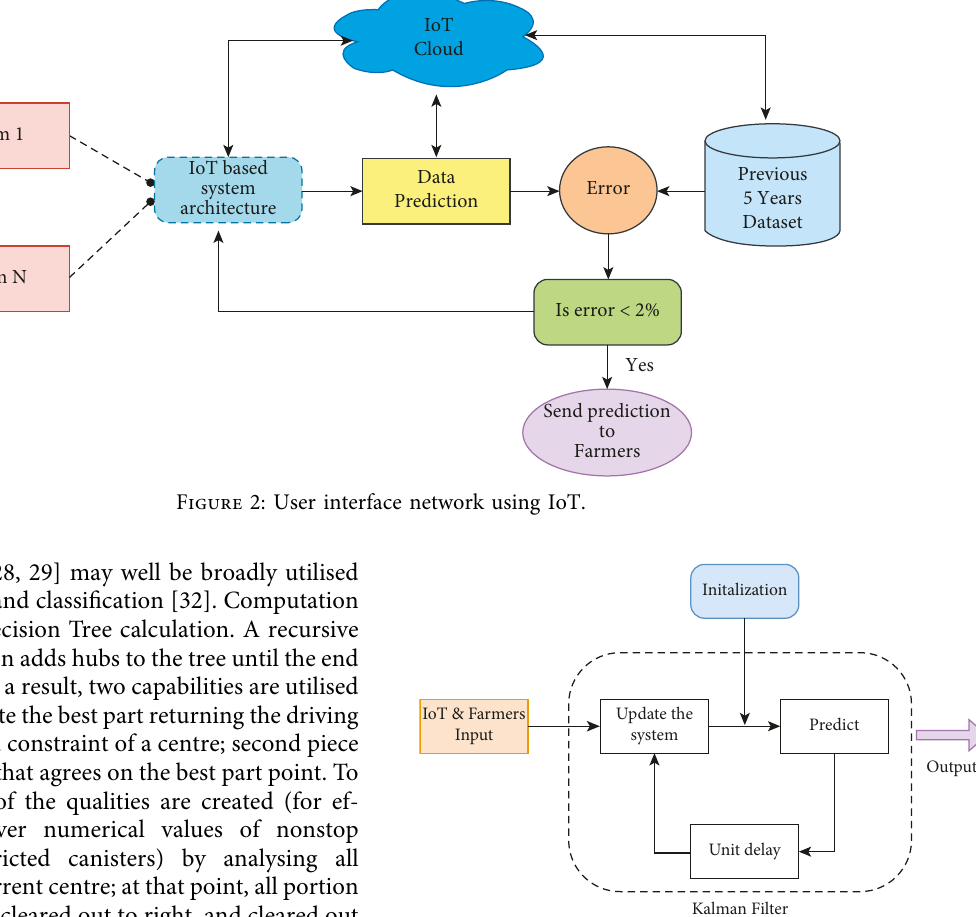
Figure 3: Kalman filter for the IoT based prediction